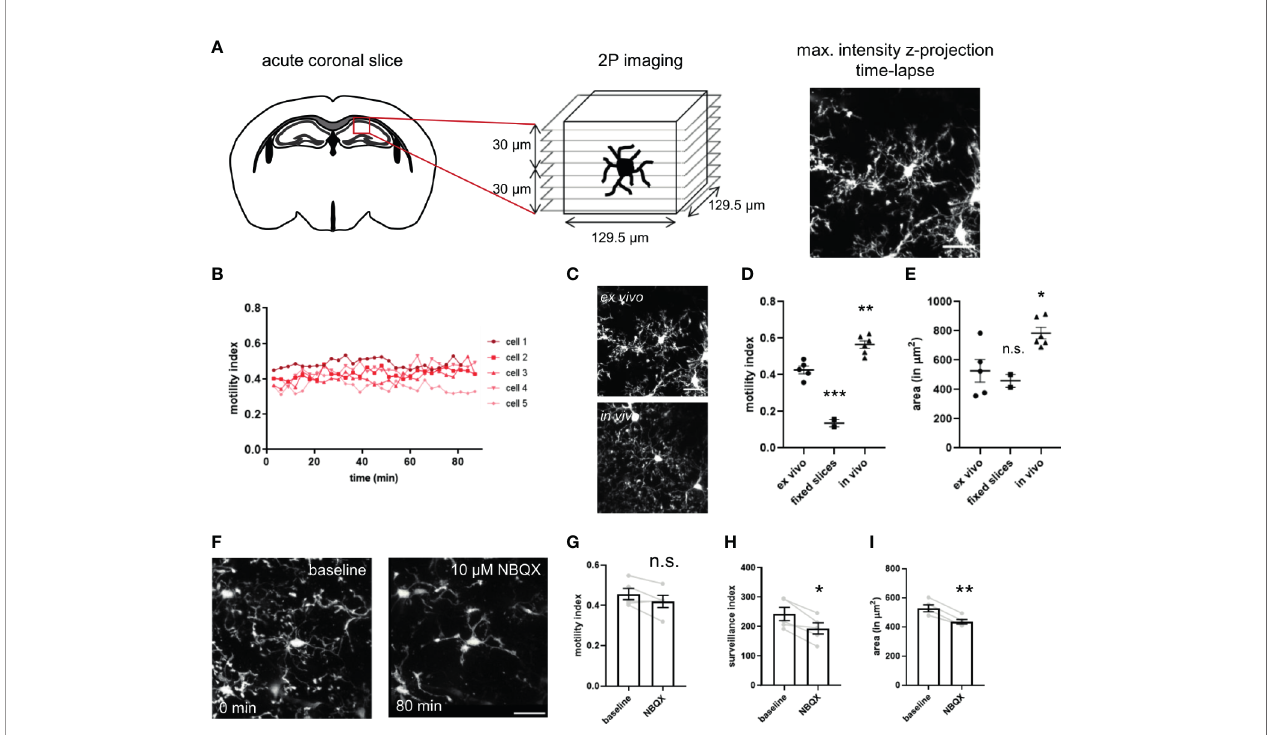
FIGURE 2 | Imaging setup of two-photon microscopy of ex vivo acutely prepared slices. (A) Freshly prepared acute coronal sections of CX3CR1-GFP mice are placed under the microscope and the region of interest is selected. After adjusting the parameters for stack acquisition, the time-lapse stack recording is initiated. (B) The motility index, calculated for each timepoint, is stable for a 80 min imaging period. (C) Representative images of microglia process complexity in the ex vivo and in vivo preparation (D) Motility index and (E) cell area of microglia imaged in ex vivo slices, PFA- fi xed slices and in vivo through a cranial window. (F) The AMPA receptor blocker NBQX induces progressive decrease in size and complexity of the rami fi ed processes. NBQX treatment leads to a marginal reduction in motility (G) , and a more severe decrease of the surveillance index (H) and microglia area (I) . For (D, E) and (G – I) One-way ANOVA multiple comparisons to ex vivo , *p<0.05, **p<0.01, ***p<0.001, n.s.>0.5 Scale bar: 20